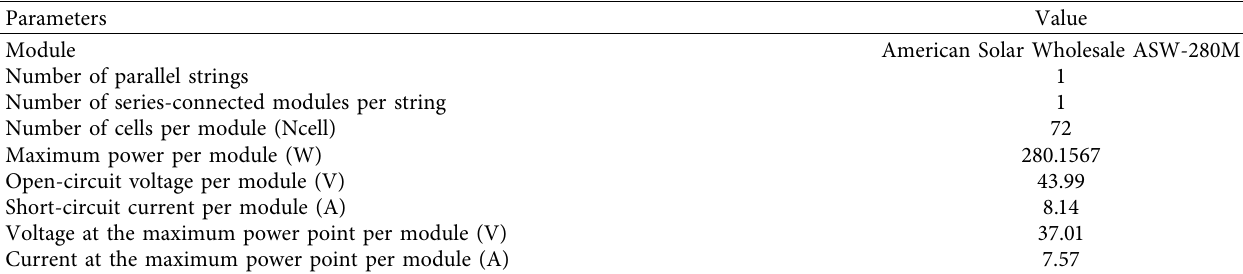
Table 2: Te concrete parameter of PV